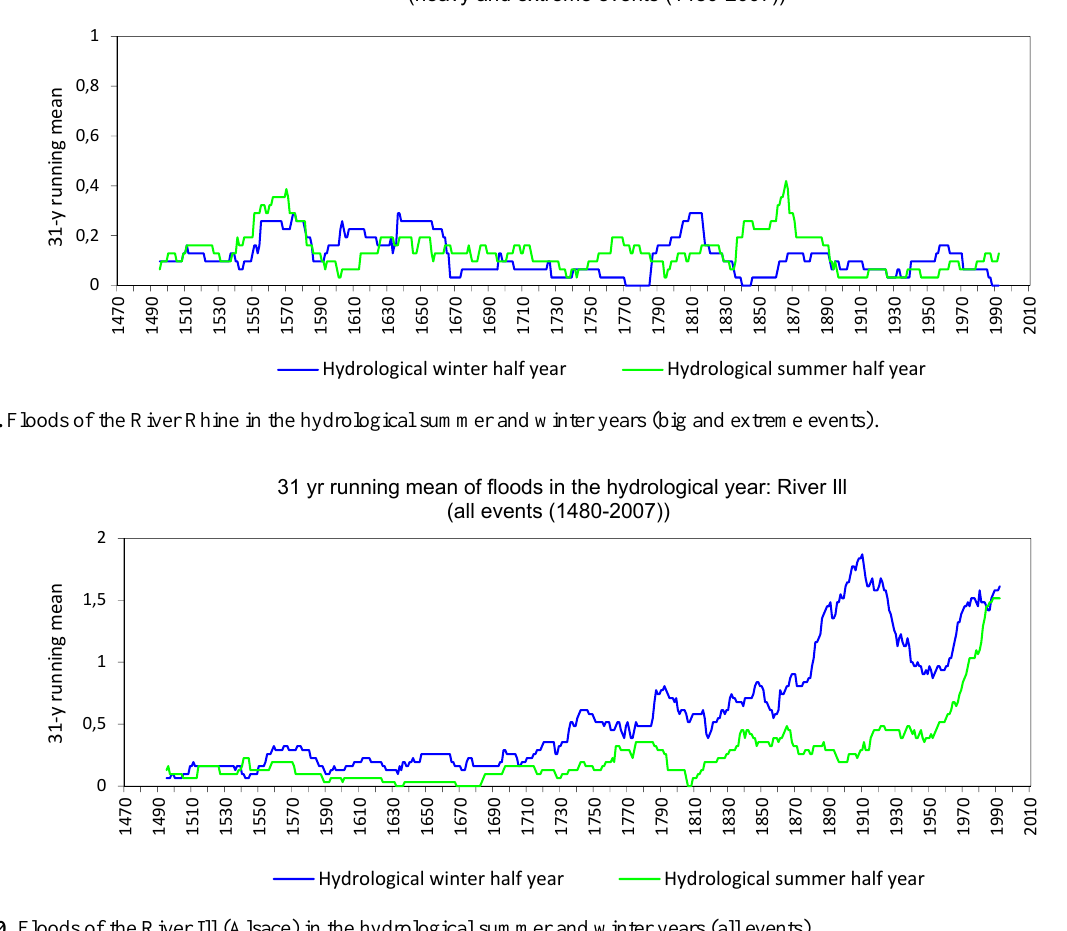
was done was the correction work on the River Ill between Meyenheim and Colmar between 1878 and 1888 (Bordmann, 2004; Himmelsbach,